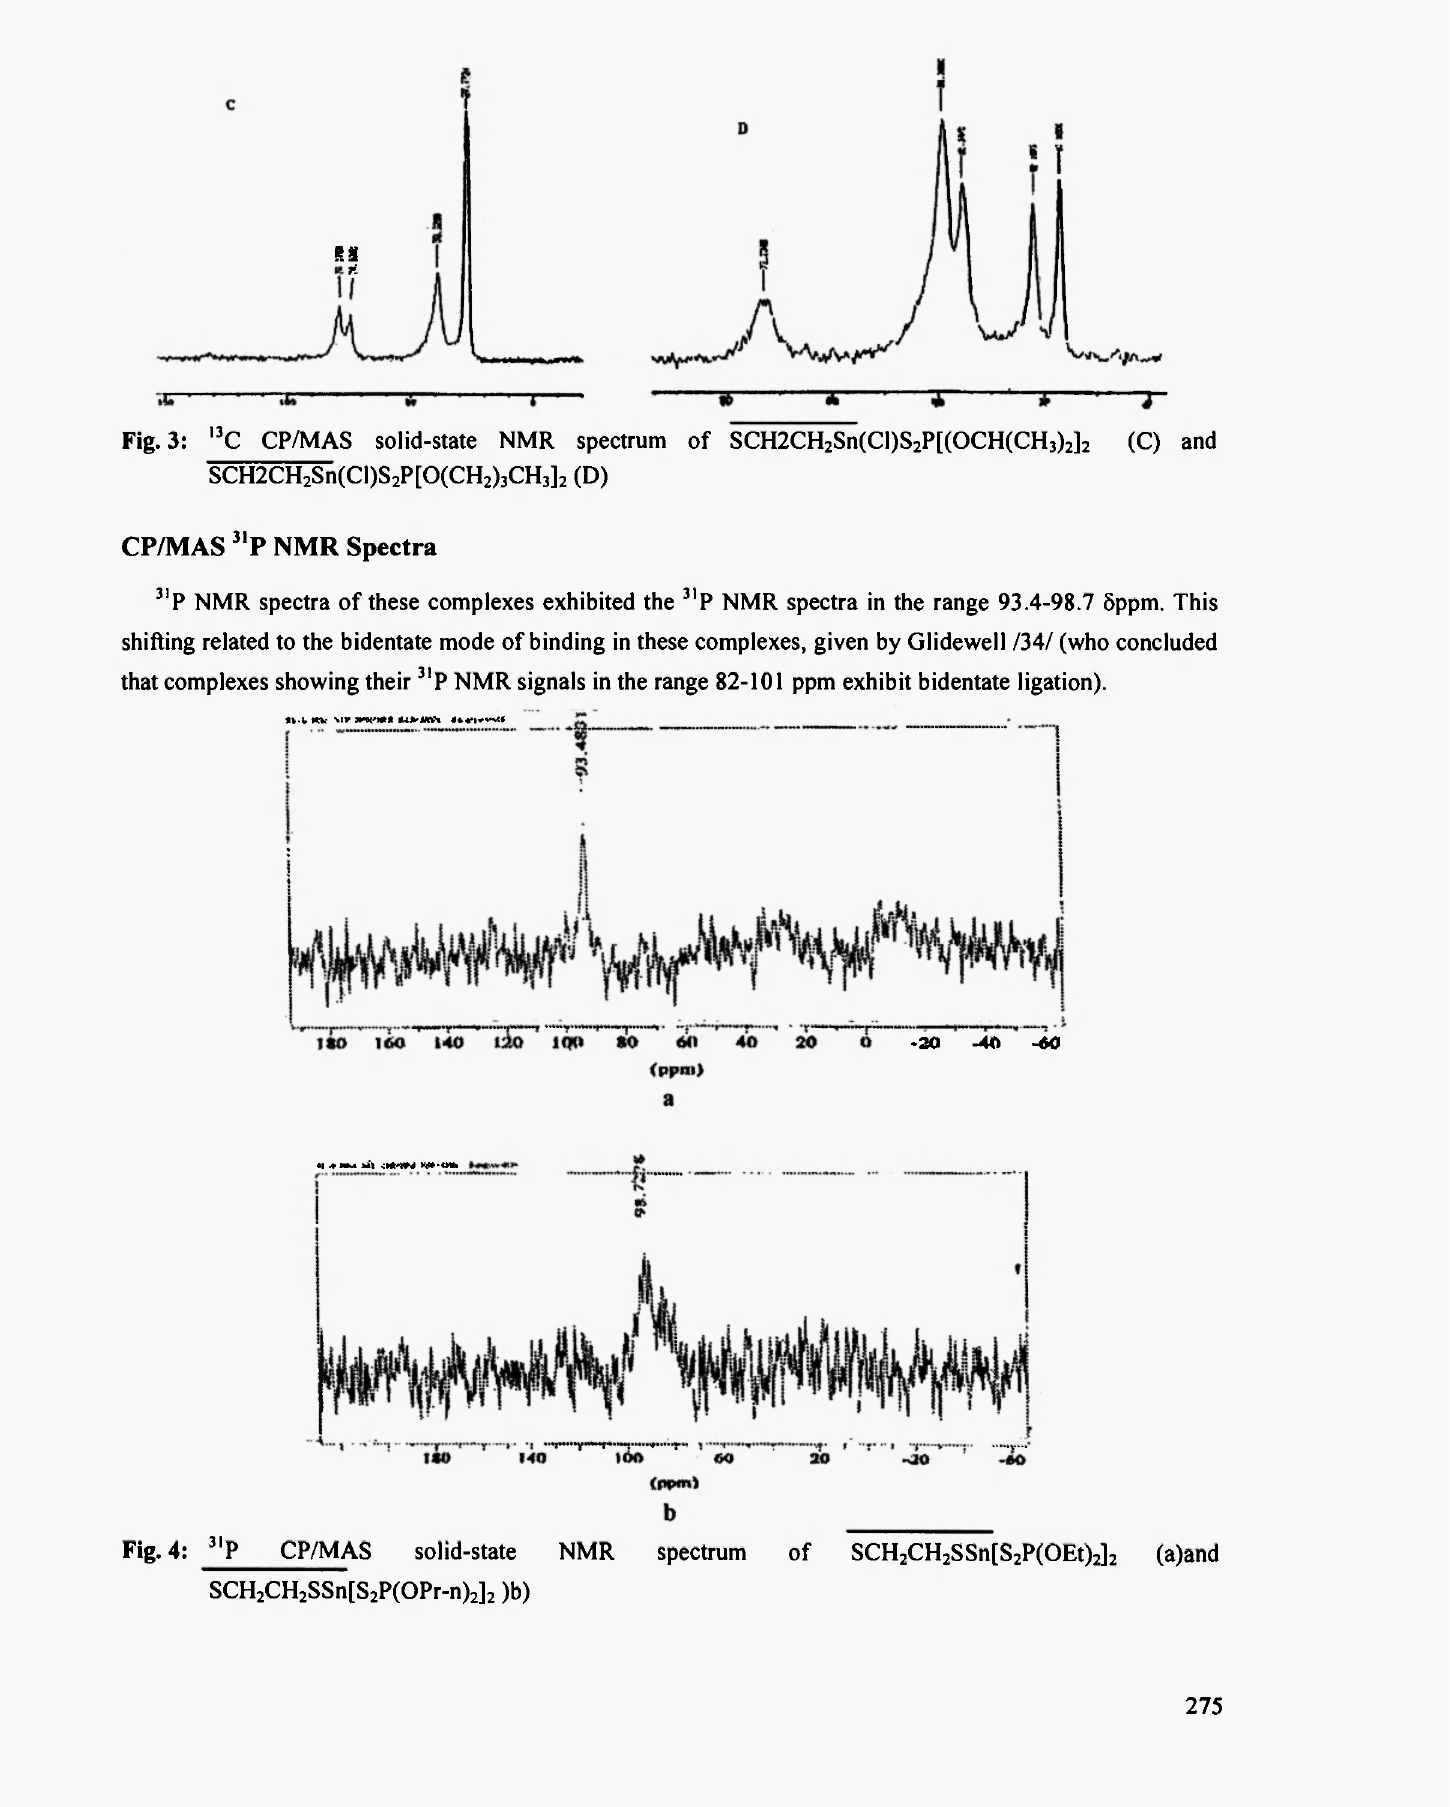
SCH CH SSn[S P(OPr-n) 2 2 2